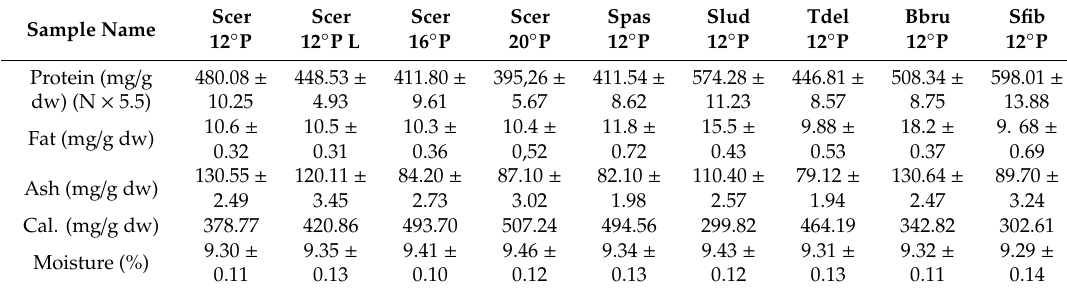
Table 3. General nutritional composition of yeast extracts made from spent yeast of beer production via a mechanical disruption method (ultrasonic sonotrode); influence of original gravity (12 ◦ P, 16 ◦ P, 20 ◦ P), time of yeast cropping (after primary fermentation vs. after cold beer lagering (L)) and yeast strain (Scer, Spas, Slud, Tdel, Bbru, Sfib); for results of ANOVA and pairwise t-test, see text; data are expressed as mean values ± confidence limits; Cal.: calculated sum parameter of carbohydrates, RNA, non-nitrogen fraction and others